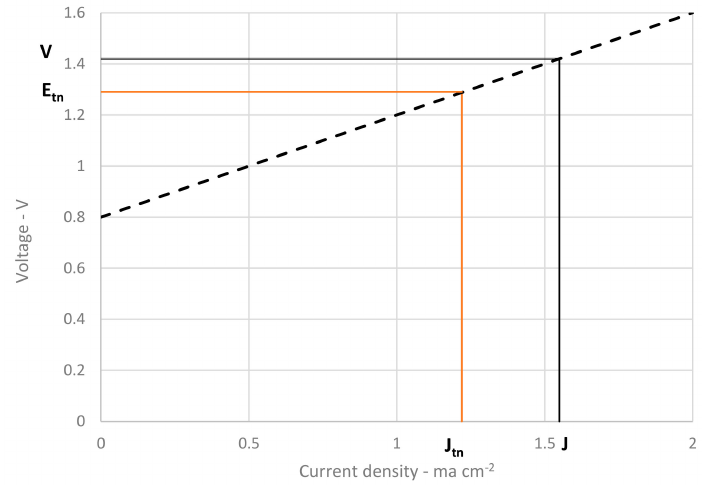
Figure 2. Example of operating condition of a solid oxide electrolyzer (SOE).